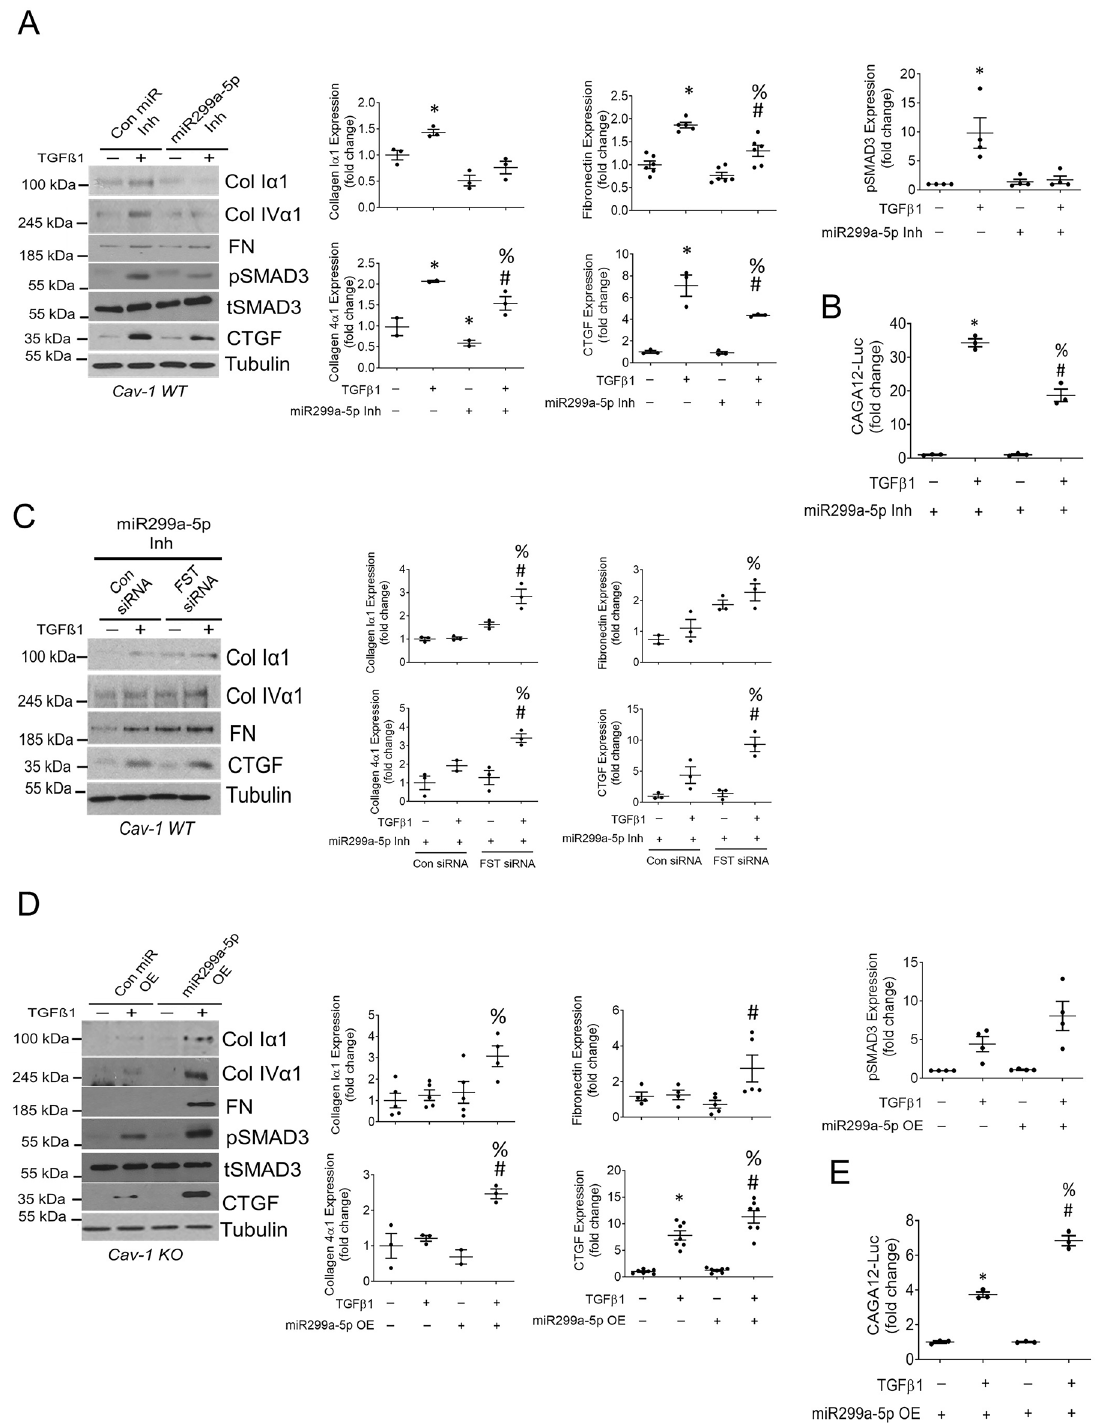
Figure 4. TGFβ1 upregulation of miR299a-5p enables ECM production through FST downregulation. ( A ) miR299a-5p inhibition blunted basal ECM and CTGF expression and decreased TGFβ1 (0.5 ng, 24 h)-induced ECM and CTGF production as well as Smad3 phosphorylation in cav-1 WT MC (n = 3, *vs con inh-con, #vs miR inh-con, %vs con inh-TGFβ1, p < 0.05). ( B ) miR299a-5p inhibition blunted TGFβ1-induced Smad3 signaling, assessed through activation of the Smad3-responsive CAGA 12 luciferase (n = 3, *vs con inh-con, #vs miR inh-con, %vs con inh-TGFβ1, p < 0.05). ( C ) FST downregulation with siRNA attenuated the ability of an miR-299a-5p inhibitor to reduce the profibrotic response to TGFβ1 (0.5 ng, 24 h) (n = 3, *vs con siRNA-con, #vs FST siRNA-con, %vs con siRNA-TGFβ1, p < 0.05). ( D ) Overexpression (OE) of miR299a-5p significantly enhanced TGFβ1 (0.5 ng, 24 h)-induced production of ECM and CTGF production while augmenting the phosphorylation of Smad3 in cav-1 KO MC (n = 3, *vs con OE-con, #vs miR OE-con, %vs con OE-TGFβ1, p < 0.05). ( E ) miR299a-5p overexpression augmented TGFβ1-induced Smad3 signaling, assessed through activation of the Smad3-responsive CAGA 12 luciferase (n = 3, *vs con OE-con, #vs miR OE-con, %vs con OE-TGFβ1, p <